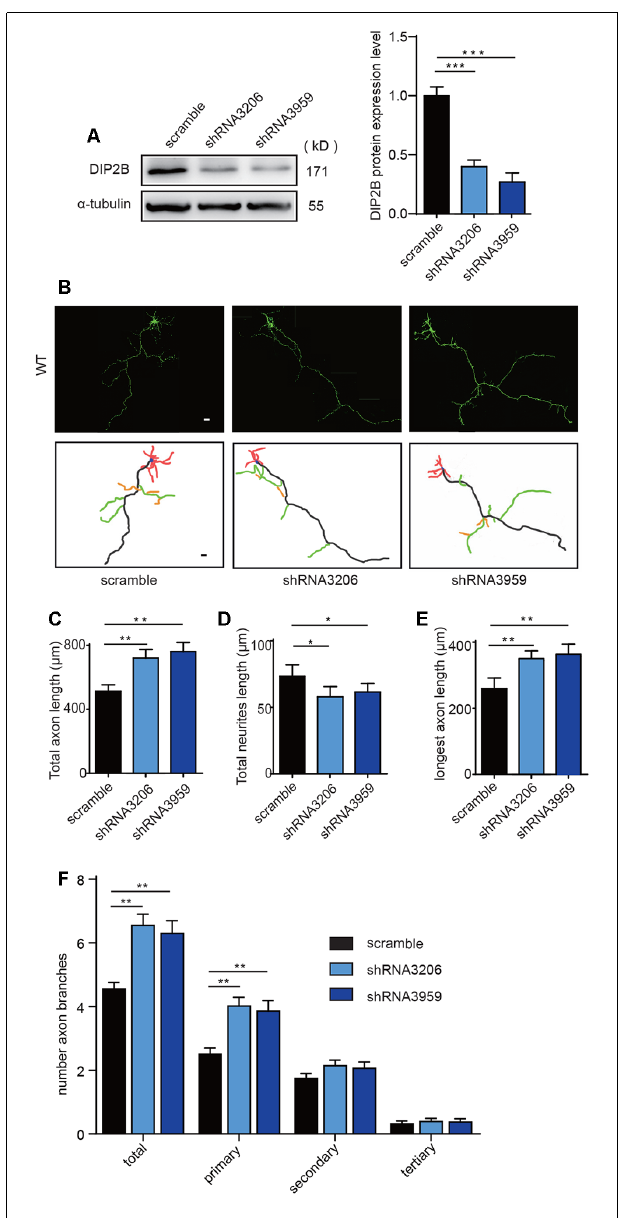
FIGURE 3 | DIP2B silencing enhances axon outgrowth. (A) Western blotting confirmed the knockdown efficiency of DIP2B shRNA 3206 and shRNA 3959 through three independent experiments. (B) Representative images of axonal development at DIV4 from cultured hippocampal neurons transfected with scrambled, shRNA 3206 and shRNA 3959. Scale bar: 20 µ m (Scramble, n = 31; shRNA 3,206, n = 36; shRNA 959, n = 36). (C) Average total axonal length from panel (B) . (D) Average total neurites length from panel (B) . (E) The average length of the longest axon from panel (B) . (F) Average axon branching from panel (B) . One-way ANOVA was used for the comparison. * p < 0.05; ** p < 0.01; *** p < 0.001; n, cell number. Error bars represent SEM. For further details, see Supplementary Table S1 .